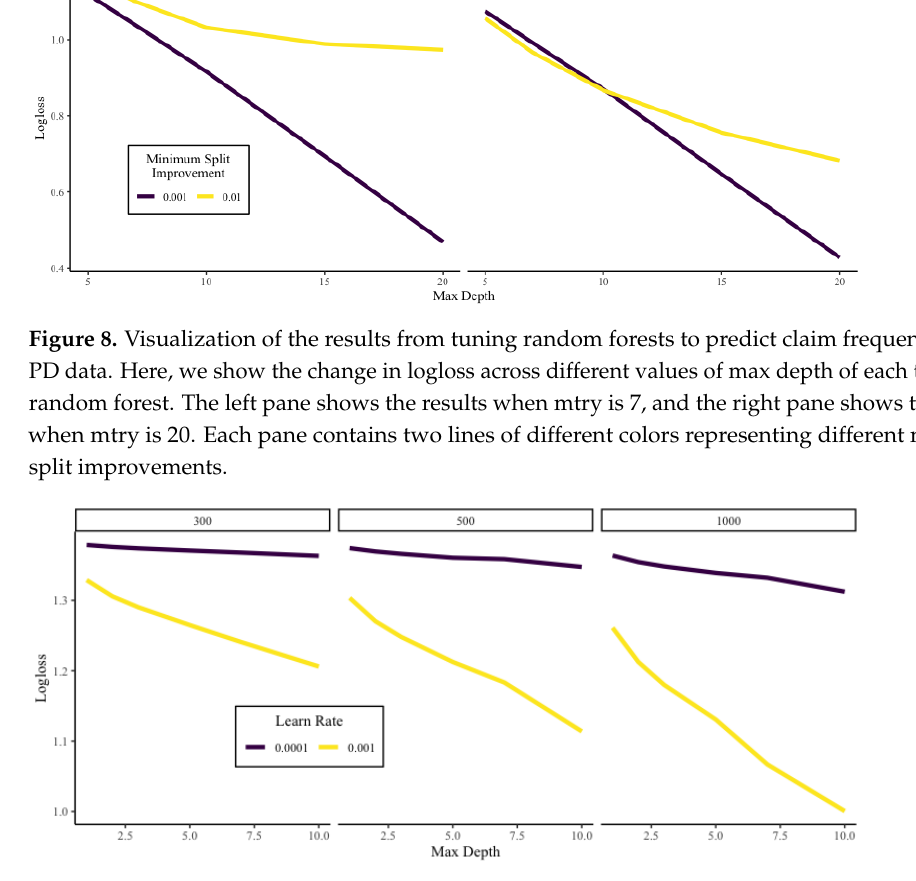
Figure 9. Visualization of the results from tuning gradient boosted forests to predict claim frequency on the PD data. Here, we show the change in logloss across different values of max depth of each tree in the gradient boosted forest. The left pane shows the results when the number of trees is 300, the middle pane shows when the number of trees is 500, and the right pane shows the results when the number of trees is 1000. Each pane contains two lines of different colors representing different learning